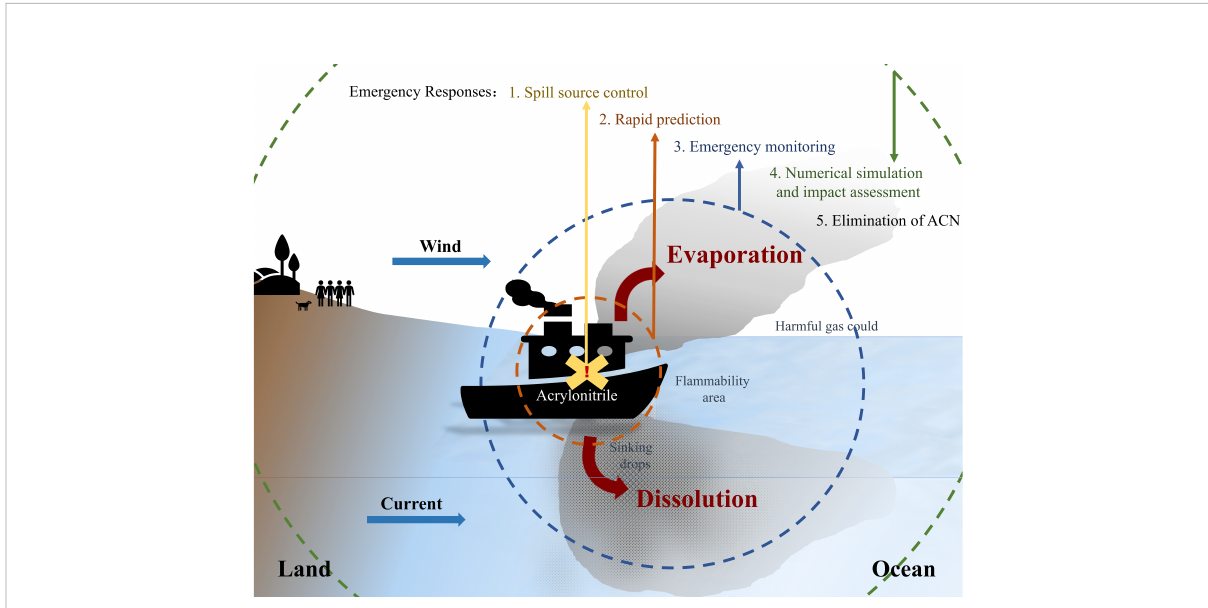
FIGURE 2 Behaviour of ACN and emergency response countermeasures to ACN maritime spill